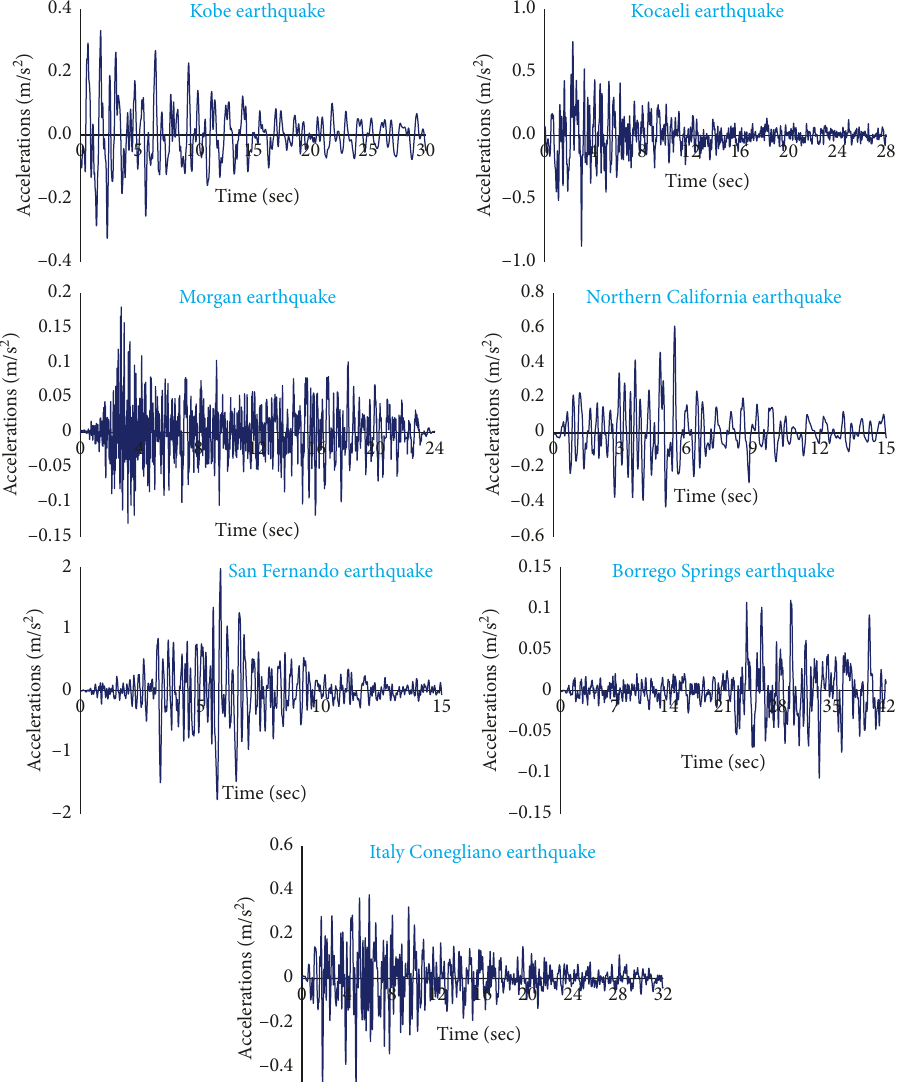
Figure 13: Acceleration-time graphics for 7 various far-fault